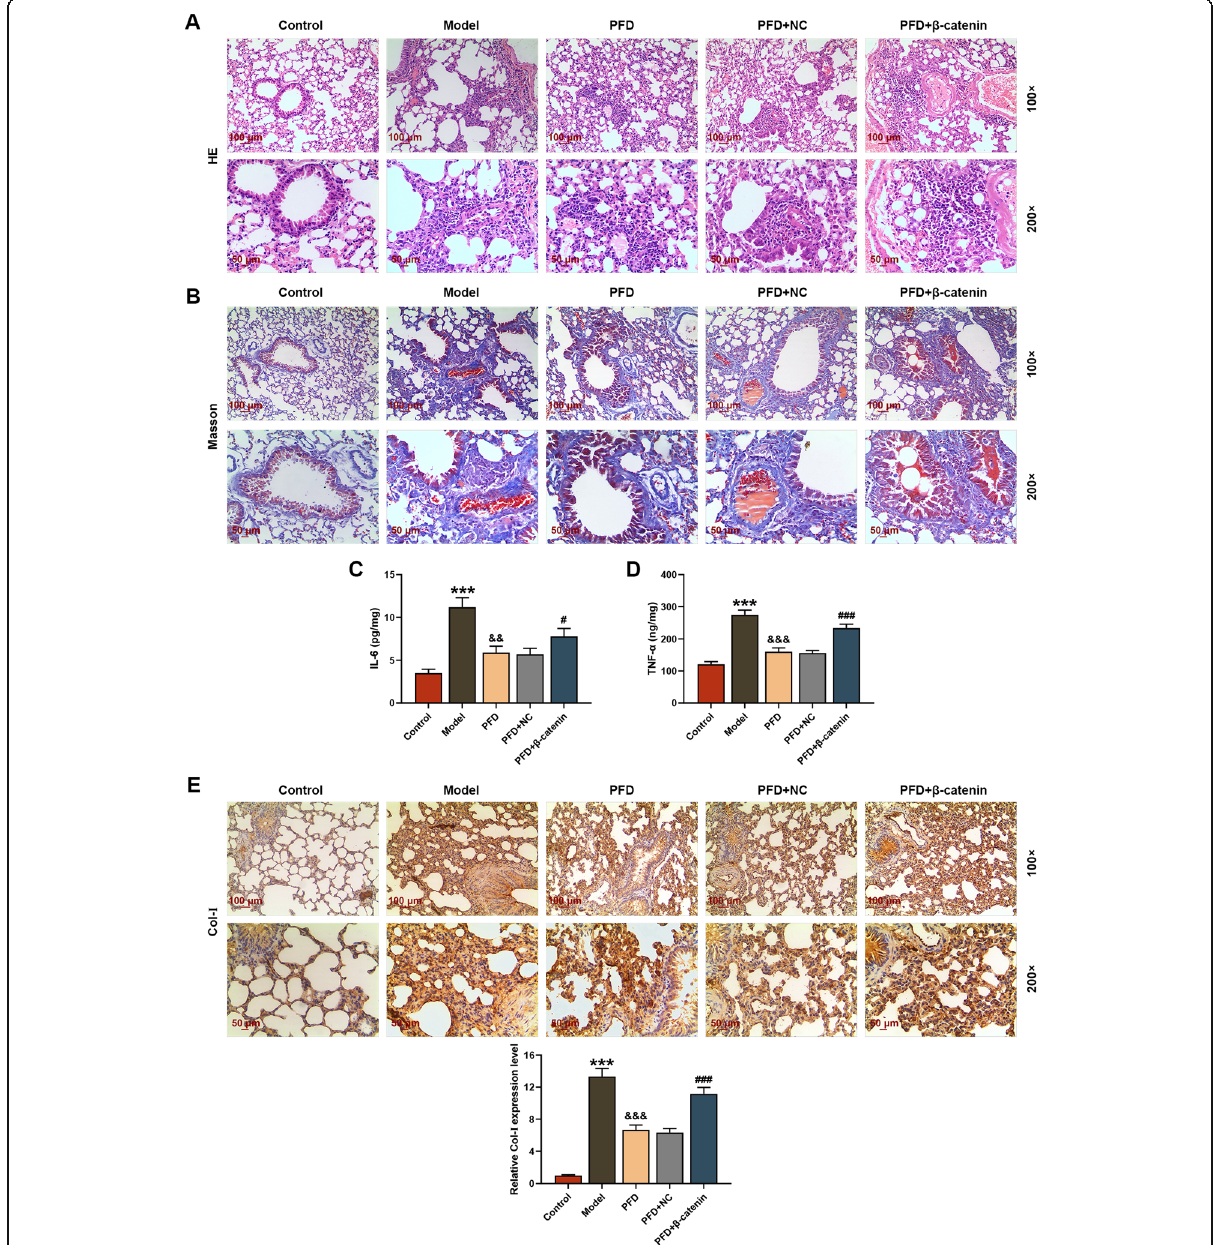
Fig. 1 Pathological changes in mice lung tissues after treatment. In this figure, mice ( n = 30) were randomly divided into equal 5 groups: control, model (Bleomycin (BLM)), pirfenidone (PFD), PFD + negative control (NC), and PFD + β -catenin. a Hematoxylin-eosin (HE) staining observed the structure and inflammatory reaction in in mice lung tissues after treatment. b Masson trichrome staining was performed to view the collagen deposition in lung tissues after treatment. c , d The levels of inflammatory factors IL-6 and TNF- α in lung tissue supernatant were measured by enzyme-linked immunosorbent assay (ELISA) assay. e The content of collagen I (Col-I) in lung tissues were detected through immunohistochemistry. *** P < 0.001, vs. control; && P < 0.01, &&& P < 0.001, vs. model; # P < 0.05, ### P < 0.001, vs. PFD + NC. N =